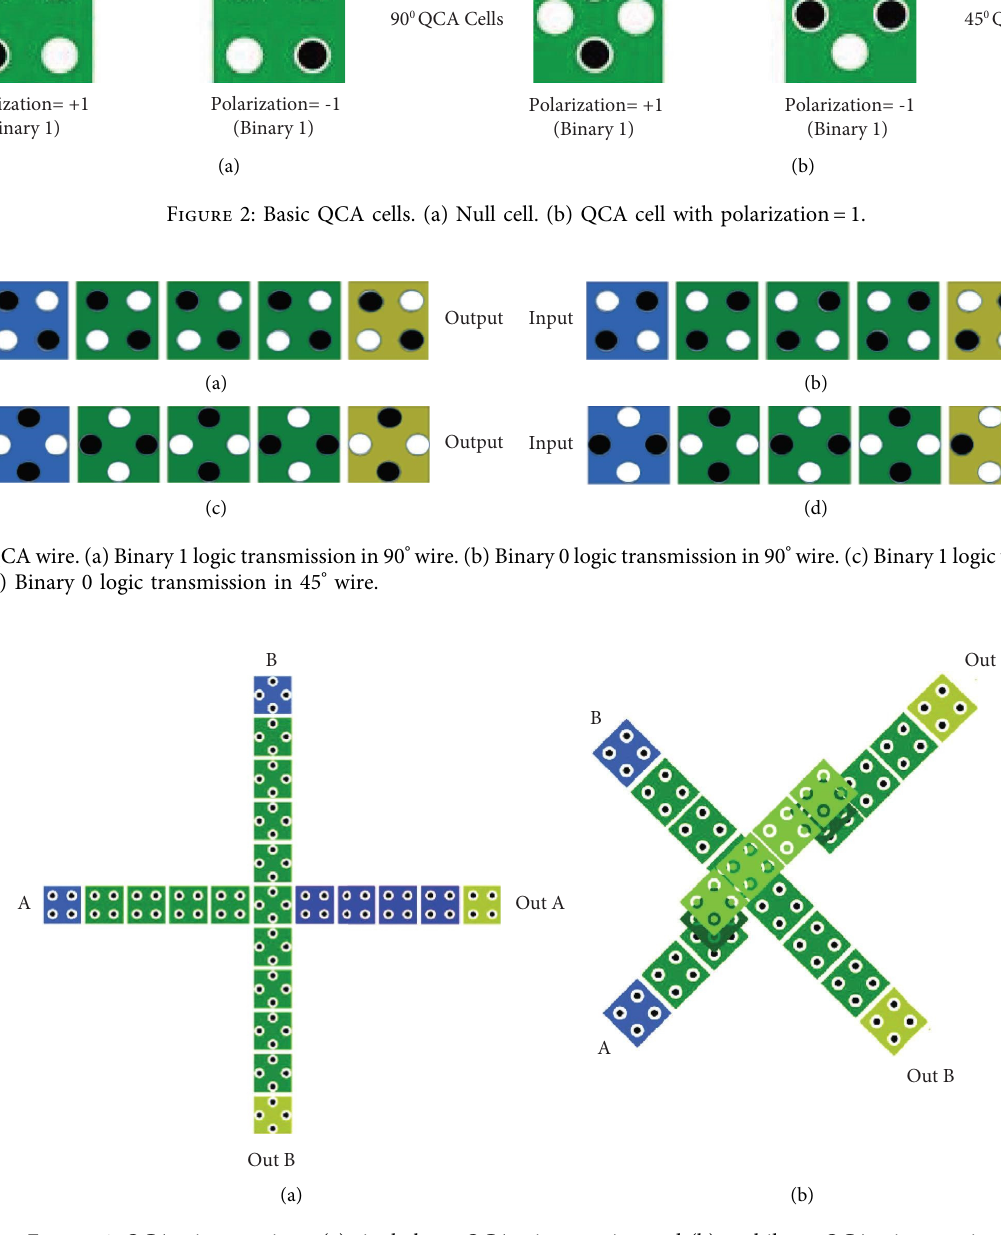
Figure 4: QCA wire crossings: (a) single layer QCA wire crossing and (b) multilayer QCA wire